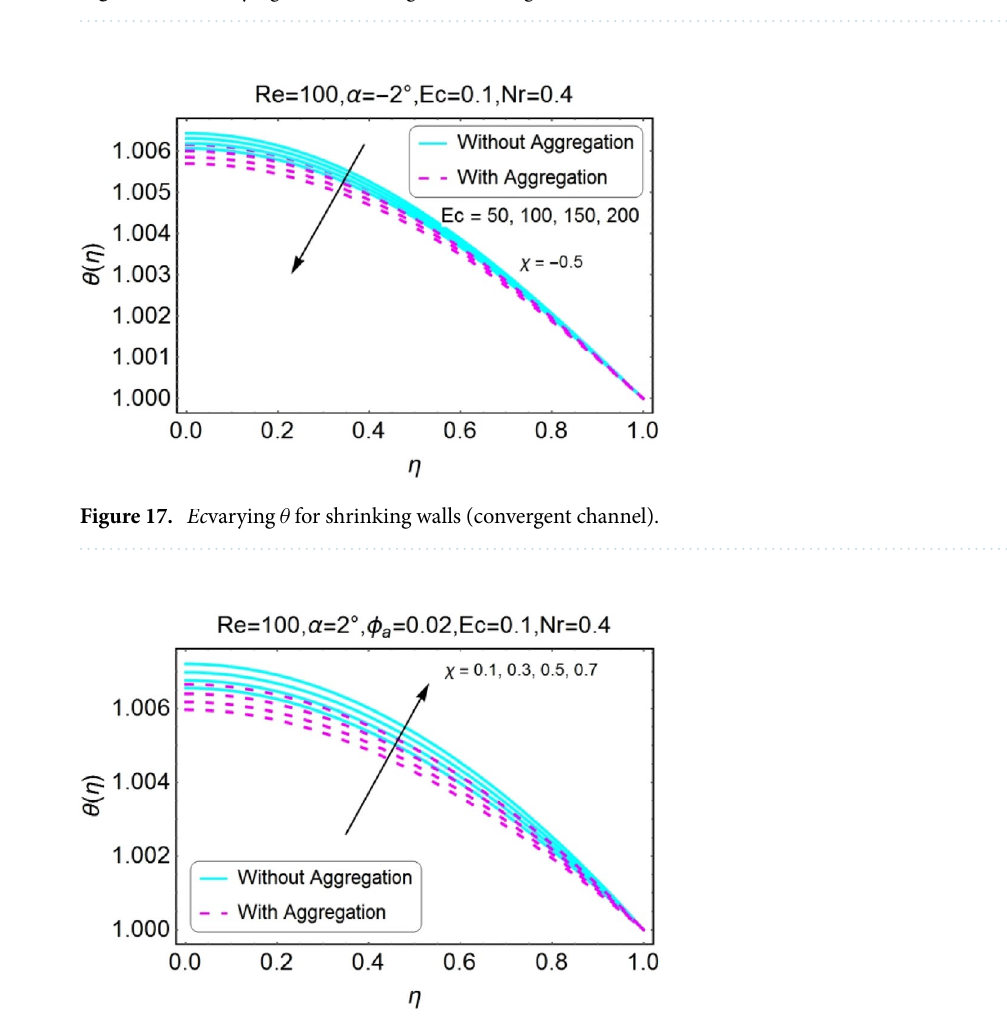
Figure 16. Ec varying θ for shrinking walls (divergent channel).